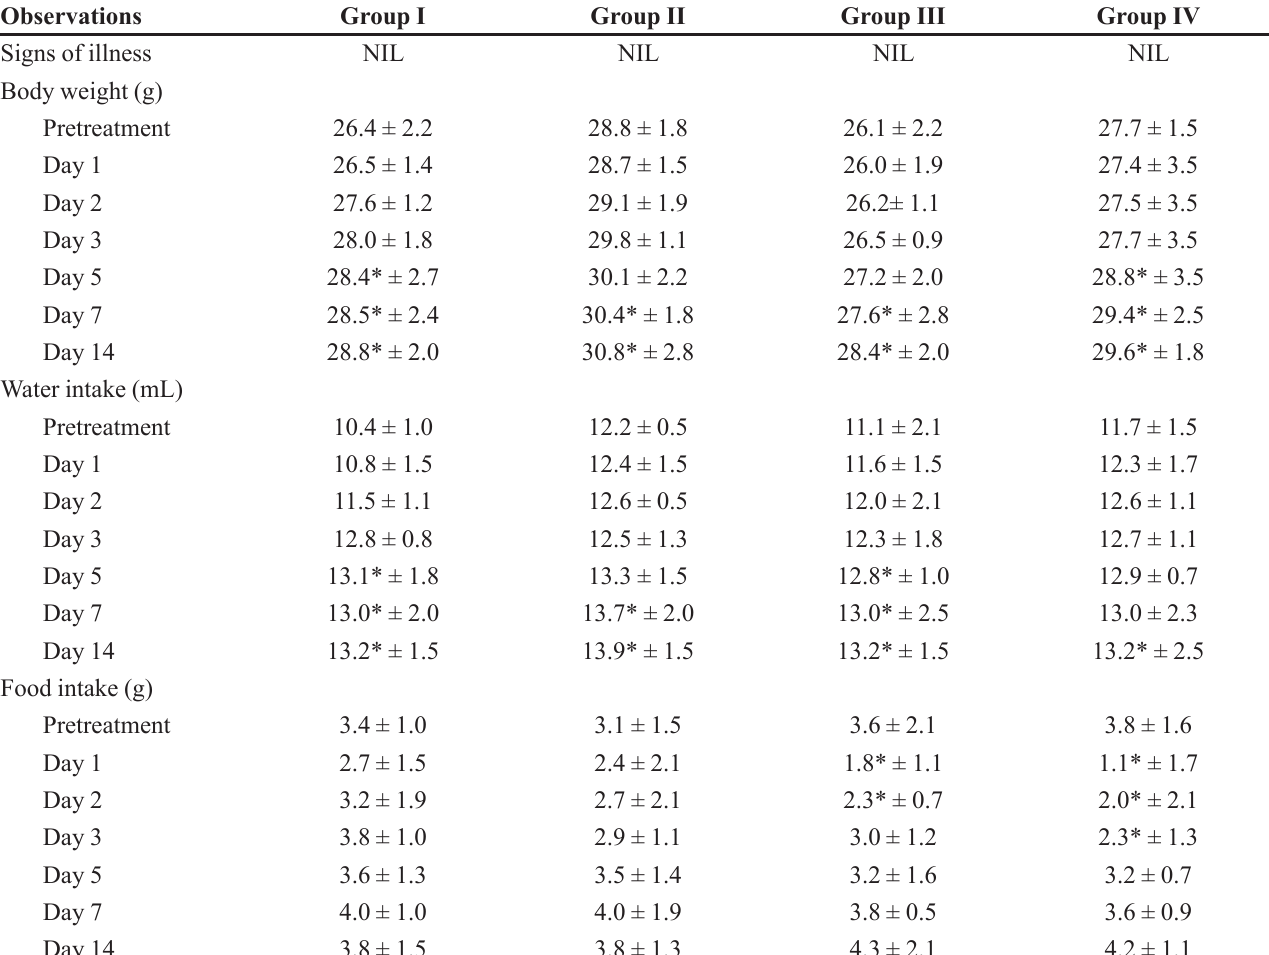
TABLE II - Observations of body weight, water and food intake study of LSH Observations